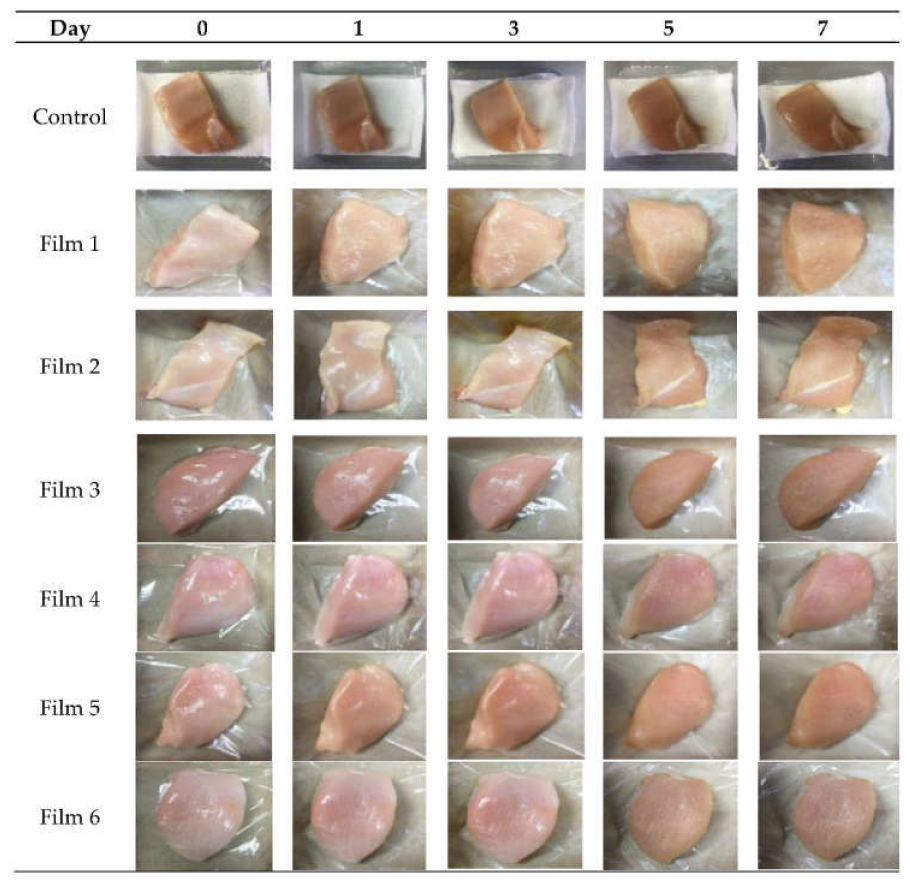
Figure 3. Overall visual quality of chicken breast meats stored in a PP container (control) and plastic film laminated trays during seven storage days at 4 ◦